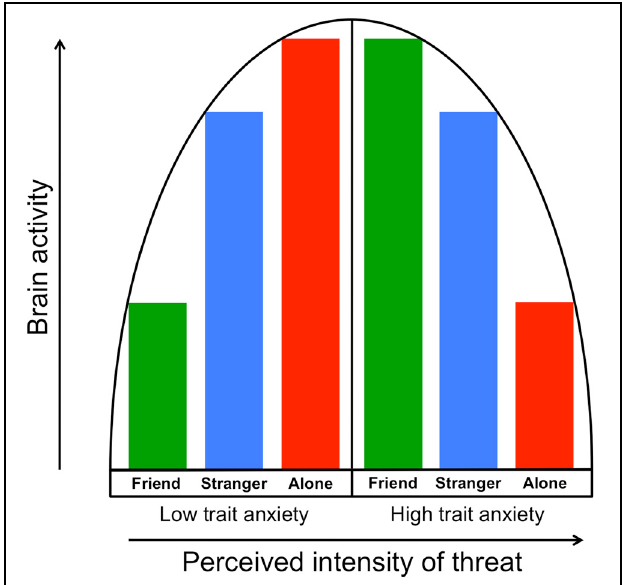
FIGURE 6 | The vigilance/disengagement model shows a curvilinear relationship between perception of threat intensity (in this case, a threat of shock) and neural threat-related activity. As illustrated in the left half of the model, individuals with low trait anxiety show gradually increasing neural output as threat perception is increased via moderation by handholding condition. Those with higher trait anxiety, as illustrated in the right half of the model, start from a higher “baseline” of perceived intensity of threat, which results in gradually decreasing neural output as perceived threat intensity